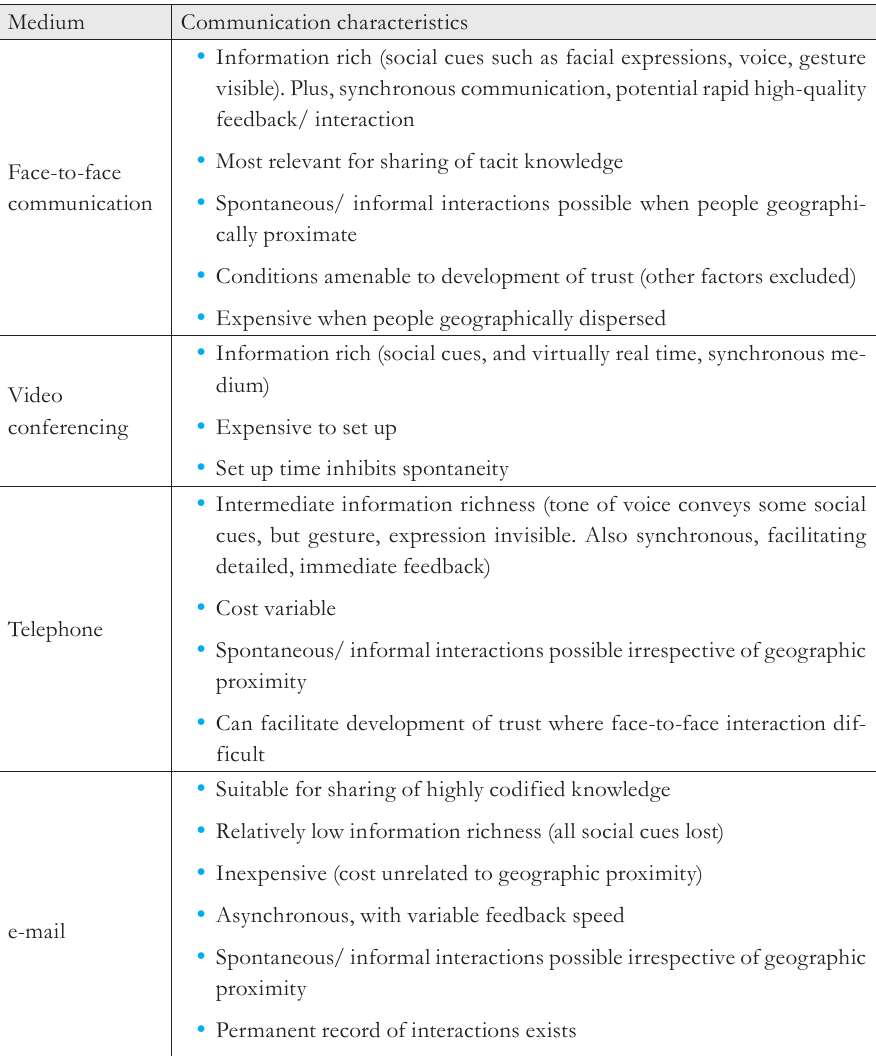
Tab. 1 - Characteristics of Various Communication Mediums. Source: Hislop